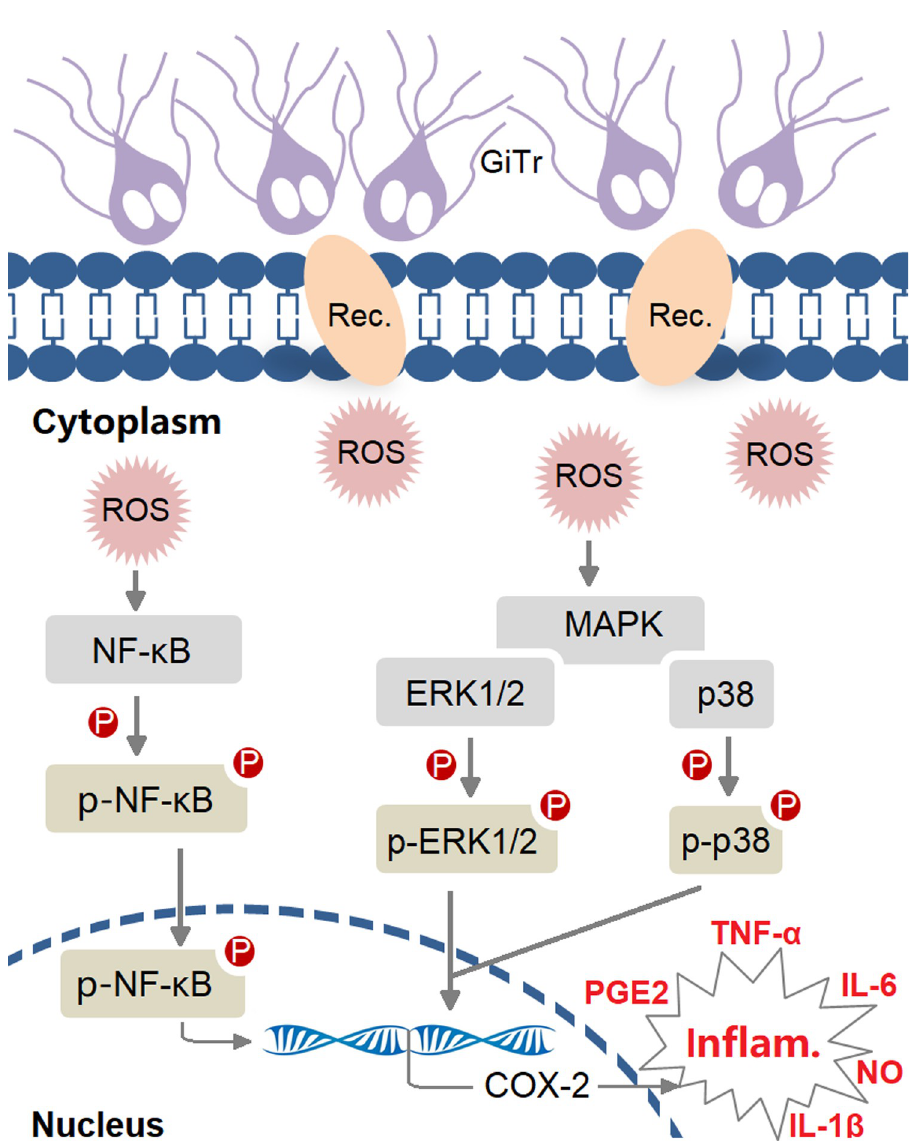
Fig 8. Schematic diagram illustrating critical regulators involved in Giardia -induced pro-inflammatory response and defense-related NO enhancement in macrophages. “GiTr” reads Giardia trophozoite.